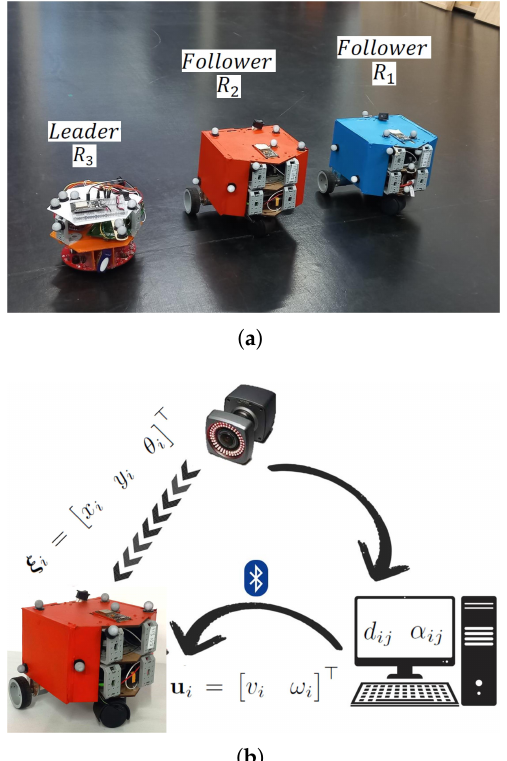
Figure 2. Overview of the experimental setup. ( a ) Differential-drive wheeled robots used in the test. ( b ) Communication flow chart.